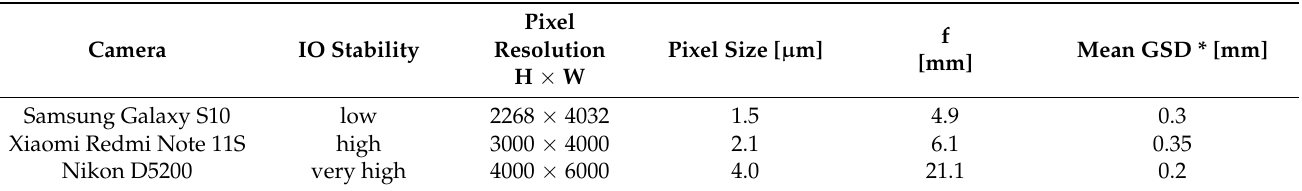
Table 2. Parameters of the cameras used in the 3D model deformation studies (the principal for the focusing of the